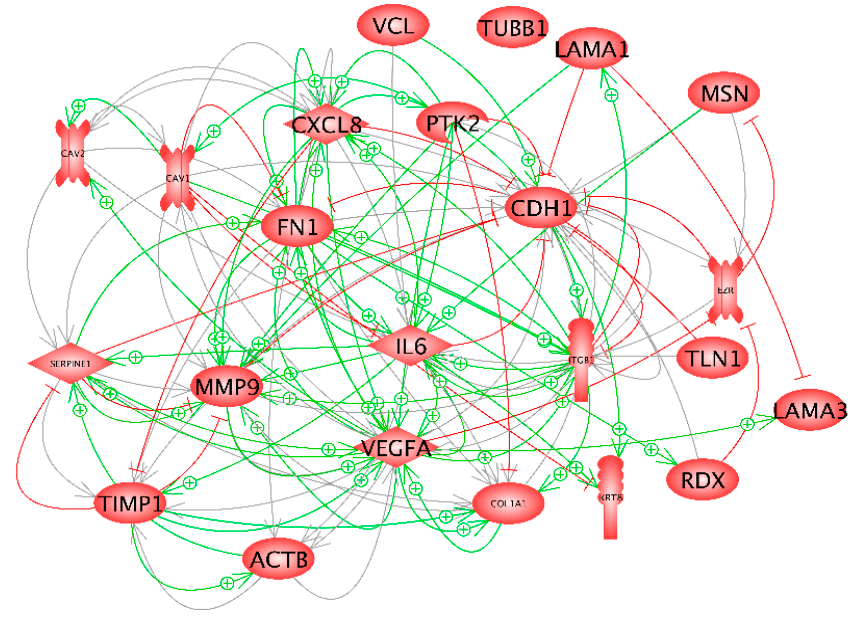
Figure10. MutualinteractionsofexpressionofthegenesexaminedwithqPCRandshowninFigures 2–4. + Signs indicate an activity-enhancing e ff ect and red lines indicate inhibition. The interaction networks were created using Elsevier Pathway Studio